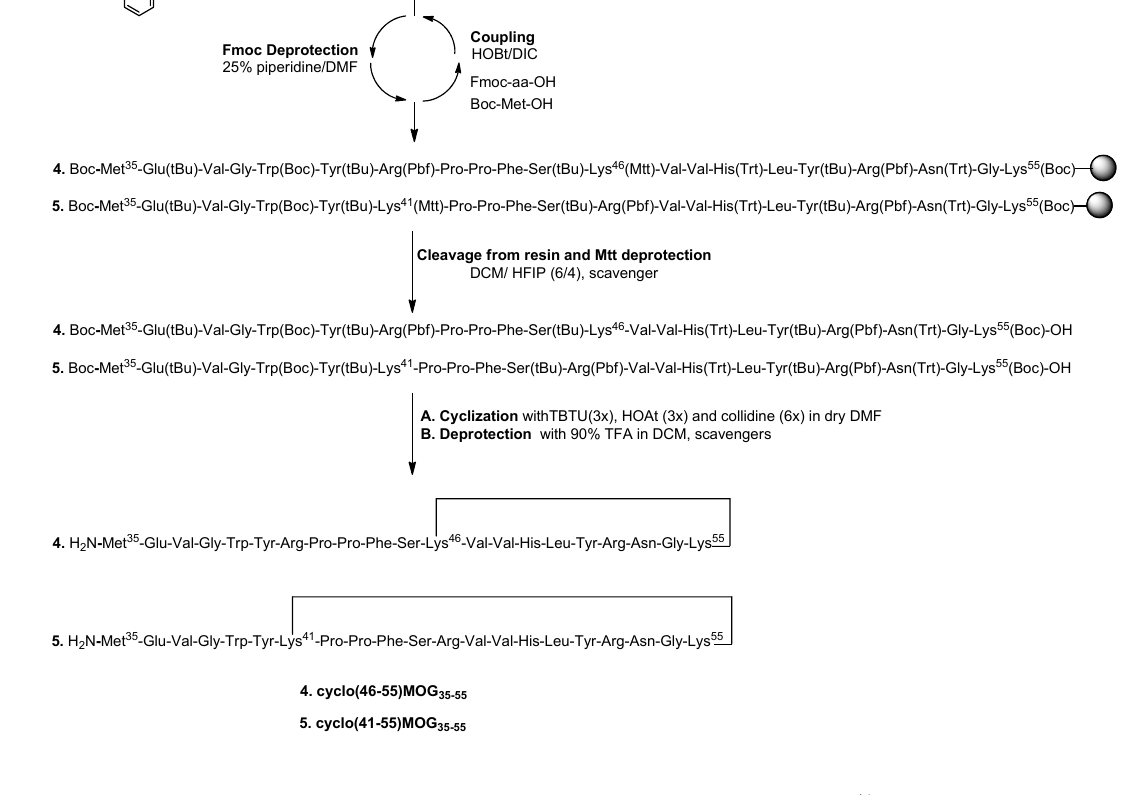
Figure 1. Analytical RP-HPLC of crude ( A ) and purified ( B ) [Ala 41 ]MOG 35–55 analogue; identification of synthesized analogue using ESI-MS ( C